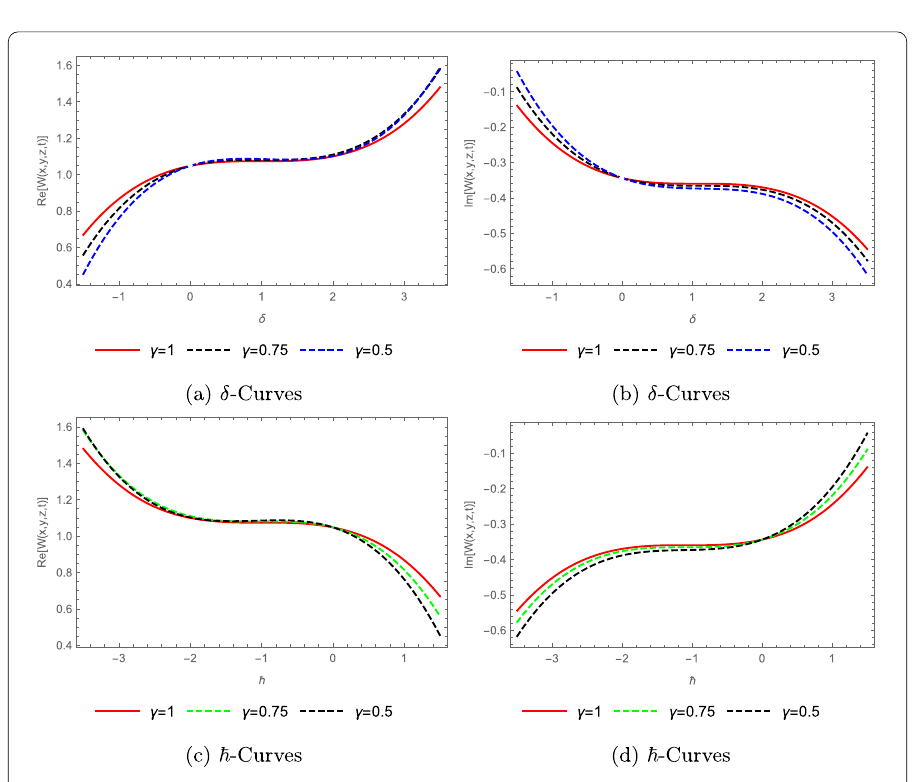
Figure 9 The curves plots of the real and imaginary parts of δ -HPTM and q-HATM solutions for Example